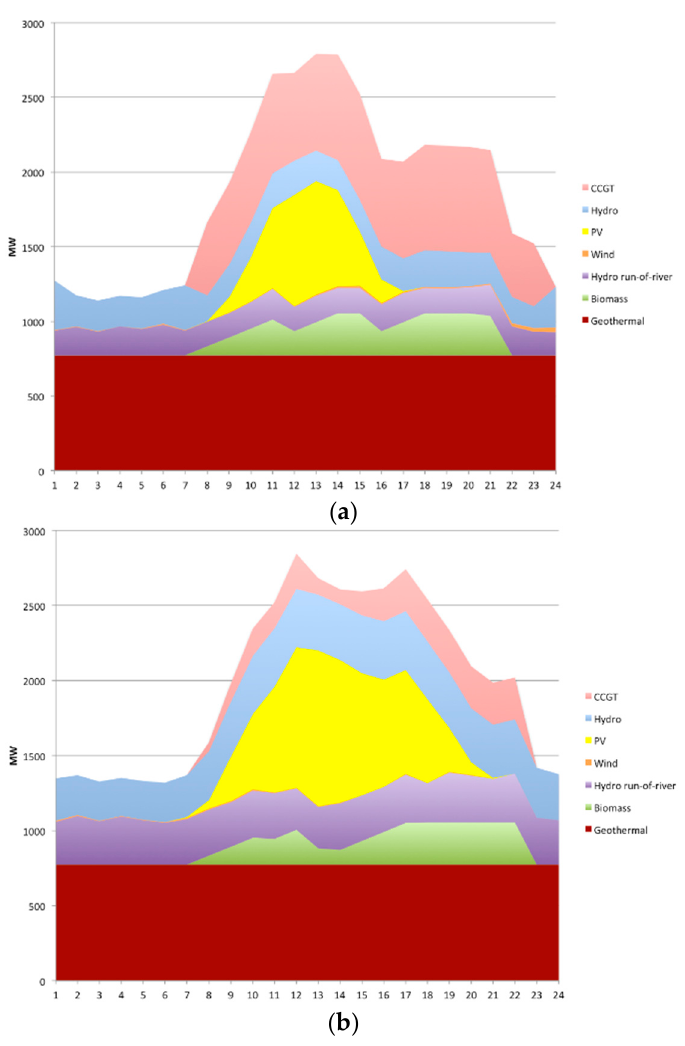
Figure 5. Generation profile—CNORD ( a ) winter and ( b ) summer.